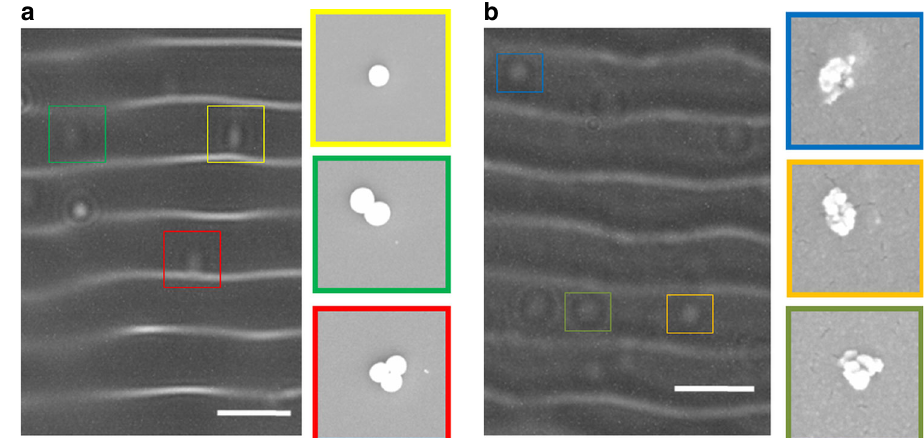
Fig. 8 Bacteria and virus detection. Acoustically actuated lens-free detection of a Staphylococcus aureus bacterial cells and b herpes simplex virus particles on a glass substrate, immobilized using speci fi c antibodies. The scale bar for lens-free images is 100 µ m. The insets (colored squares) show the SEM images of the corresponding bioparticles. The SEM fi eld-of-view is 5 µ m × 5 µ m for bacterial cells ( a ) and 1 µ m × 1 µ m for virus particles ( b ).